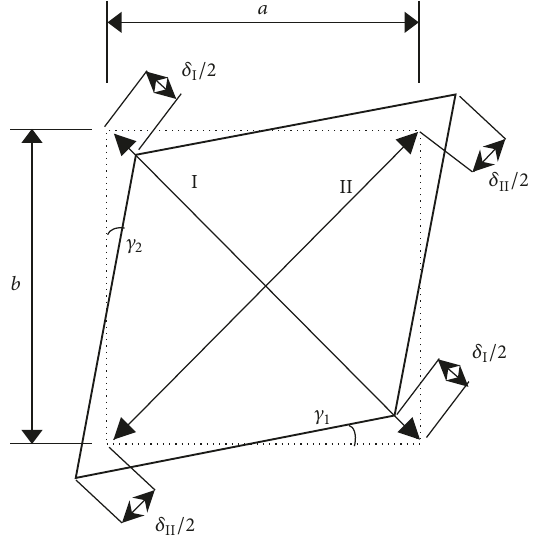
Figure 10: Evaluation of joint shear deformation.